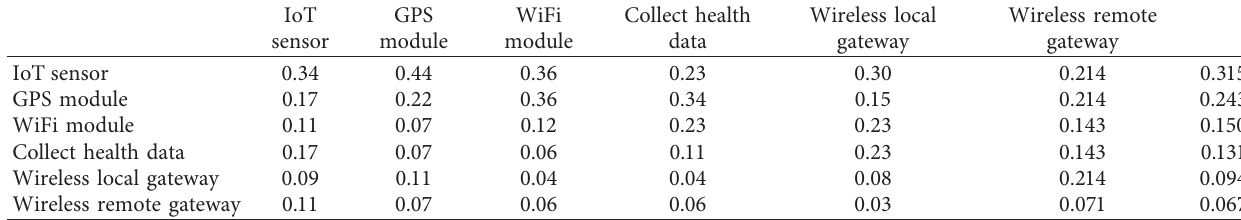
Table 4: Pairwise comparison.